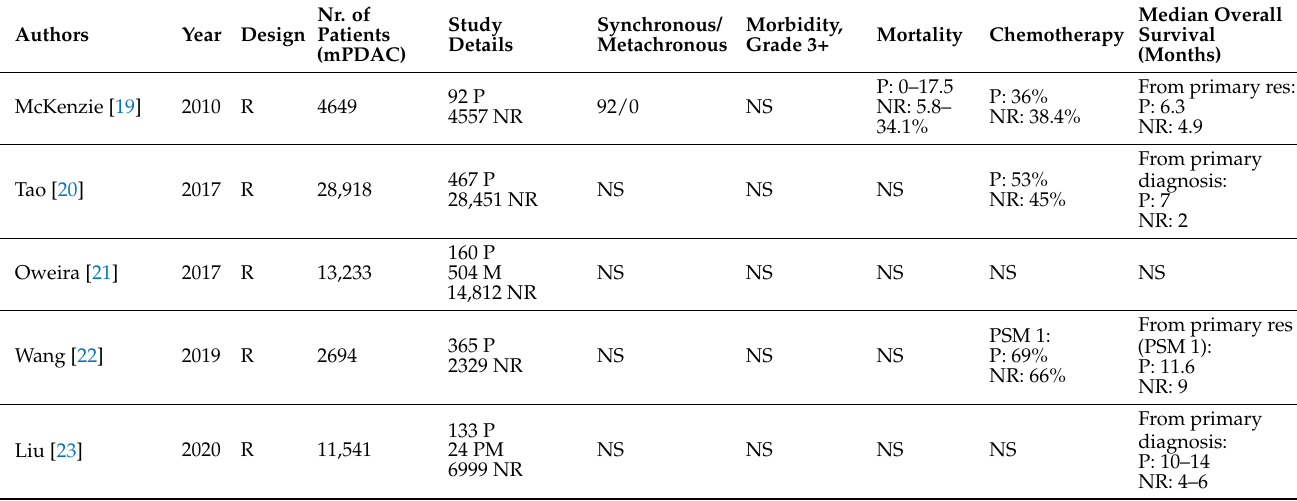
Table 1. Primary tumor resection in mPDAC. NS = not specified; R = retrospective; P = primary resection; NR = no resection; M = metastatic resection (unknown whether this was in combination with primary resection); PM = primary + metastatic resection; PSM = propensity score